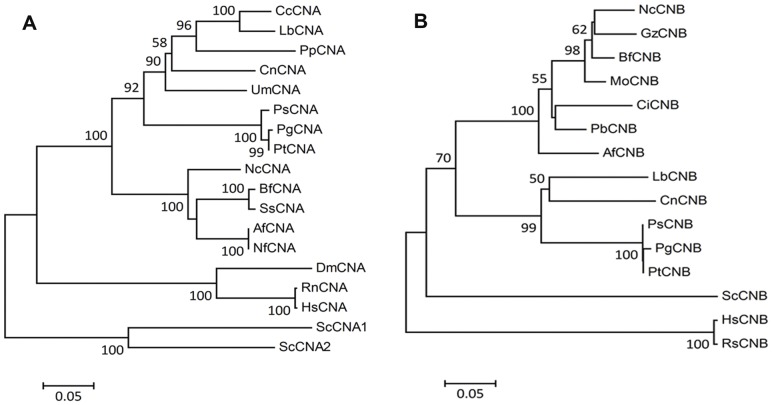
Phylogenetic analyses of CNA and CNB genes.A: AfCNA (Aspergillus fumigatus, XP_753703), BfCNA (Botryotinia fuckeliana, XP_001558972), CcCNA (Coprinopsis cinerea, XP_001838986), CnCNA (Cryptococcus neoformans var. grubii, AAB97372), DmCNA (Drosophila melanogaster, NP_727985), HsCNA (Homo sapiens, NP_000936), LbCNA (Laccaria bicolor, XP_001884713), NcCNA (Neurospora crassa, XP_961193), NfCNA (Neosartorya fischeri, XP_001259754), PgCNA (Puccinia graminis f. sp. tritici, EFP89050), PpCNA (Postia placenta, XP_002470453), PsCNA (Puccinia striiformis f. sp. tritici, JX424819), PtCNA (Puccinia triticina, PTTG_07903), RnCNA (Rattus norvegicus, BAA14083), ScCNA1 (Saccharomyces cerevisiae, SCRG_04371), ScCNA2 (Saccharomyces cerevisiae, SCRG_01842), SsCNA (Sclerotinia sclerotiorum, XP_001597594), UmCNA (Ustilago maydis, AAP48999). B: AfCNB (Aspergillus flavus, XP_002378292), BfCNB (Botryotinia fuckeliana, XP_001555369), CiCNB (Coccidioides immitis, XP_001248933), CnCNB (Cryptococcus neoformans var. neoformans, XP_57033), GzCNB (Gibberella zeae, XP_387580), HsCNB (Homo sapiens, NP_000936), LbCNB (Laccaria bicolor, XP_001884421), MoCNB (Magnaporthe oryzae, ADD84607), NcCNB (Neurospora crassa, CAA73345), PbCNB (Paracoccidioides brasiliensis, XP_002795006), PgCNB, (Puccinia graminis tritici, EFP78352), PsCNB (Puccinia striiformis f. sp. tritici, JX424820), PtCNB (Puccinia triticina, PTTG_02210), RsCNB (Rattus sp., BAA03318), ScCNB (Saccharomyces cerevisiae, SCRG_03838). The unrooted phylograms were constructed based on NJ analysis. Confidence of groupings was estimated by using 1,000 bootstrap replicates. Numbers next to the branching point indicate the percentage of replicates supporting each branch.